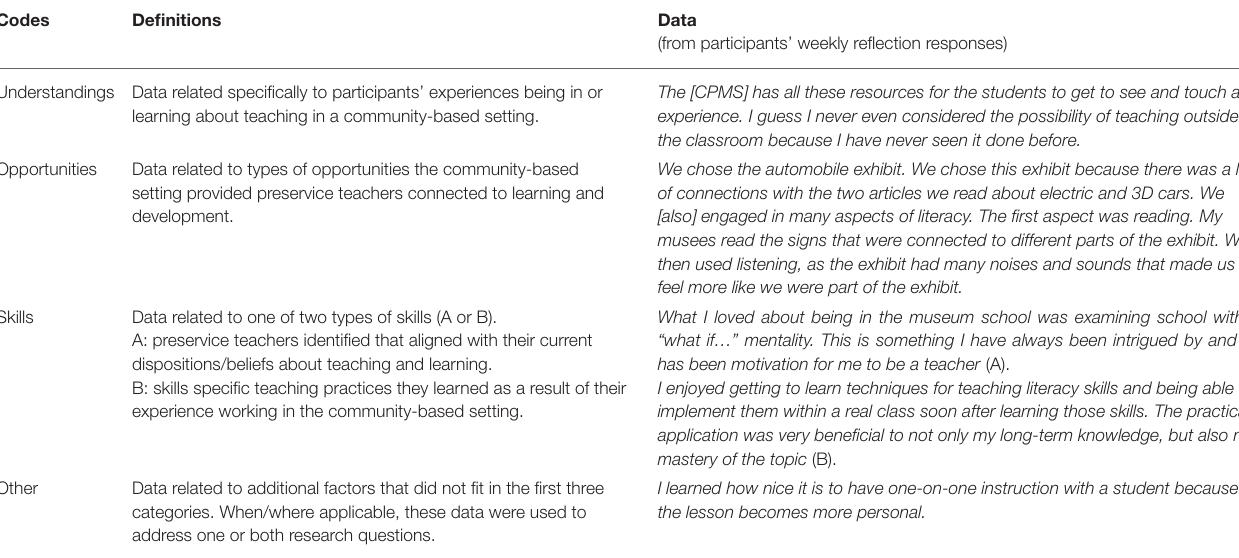
TABLE 1 | Codes, definitions, and data. Codes Definitions Data